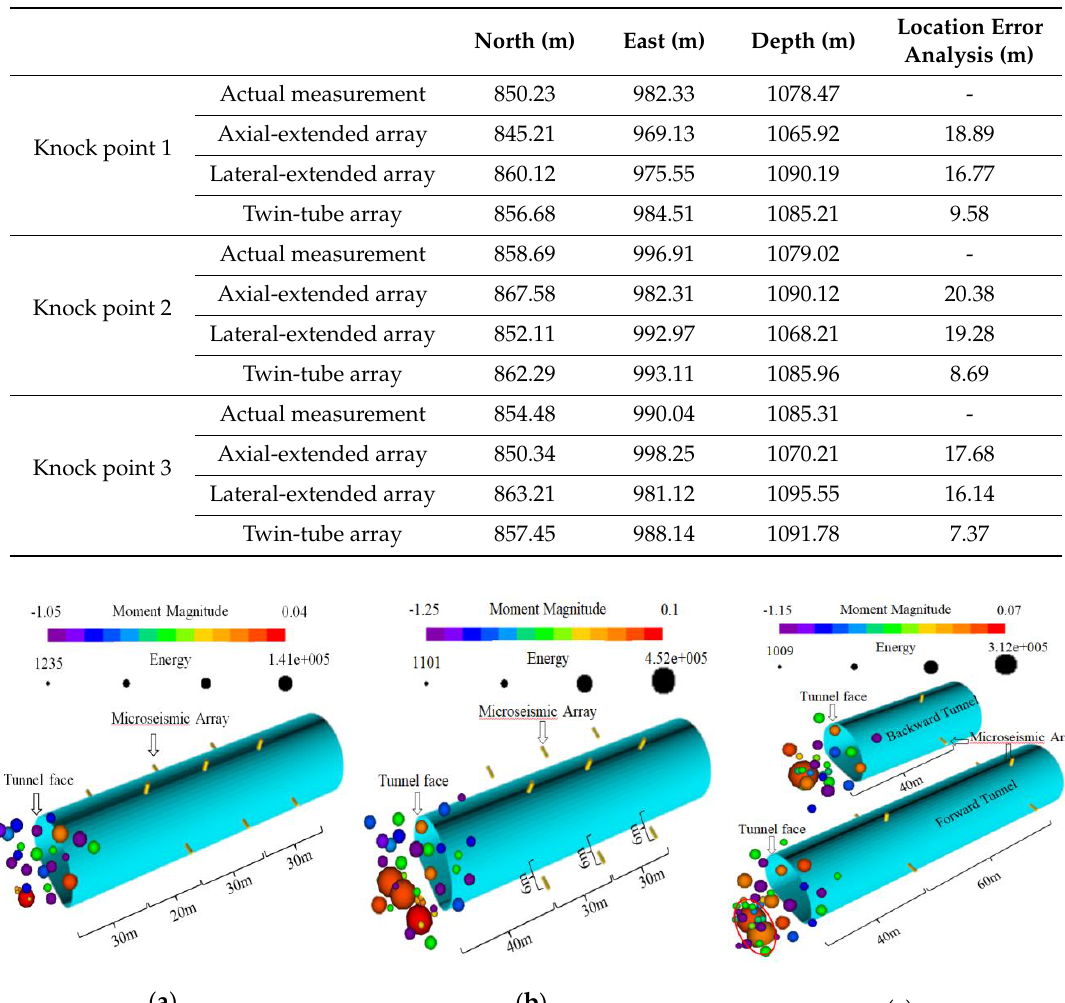
Table 1. Artificial knock test results. Knock points 1, 2, and 3 were located on the left wall, right wall, and vault of the same section of the tunnel, respectively. The table shows the experimentally measured and calculated coordinates of the knock points of the non-enclosed arrays.